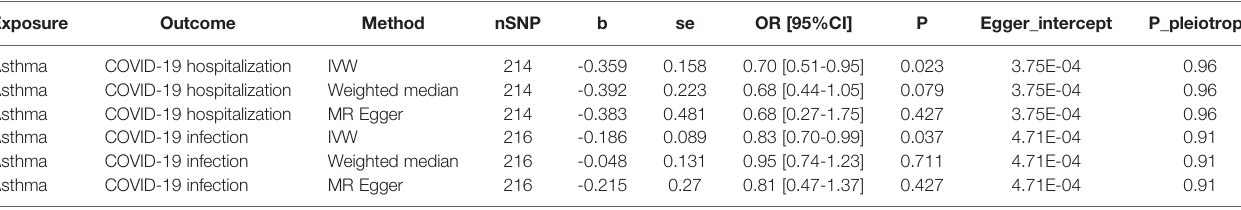
TABLE 1 | Causal effects of asthma on the COVID-19 outcomes. Exposure